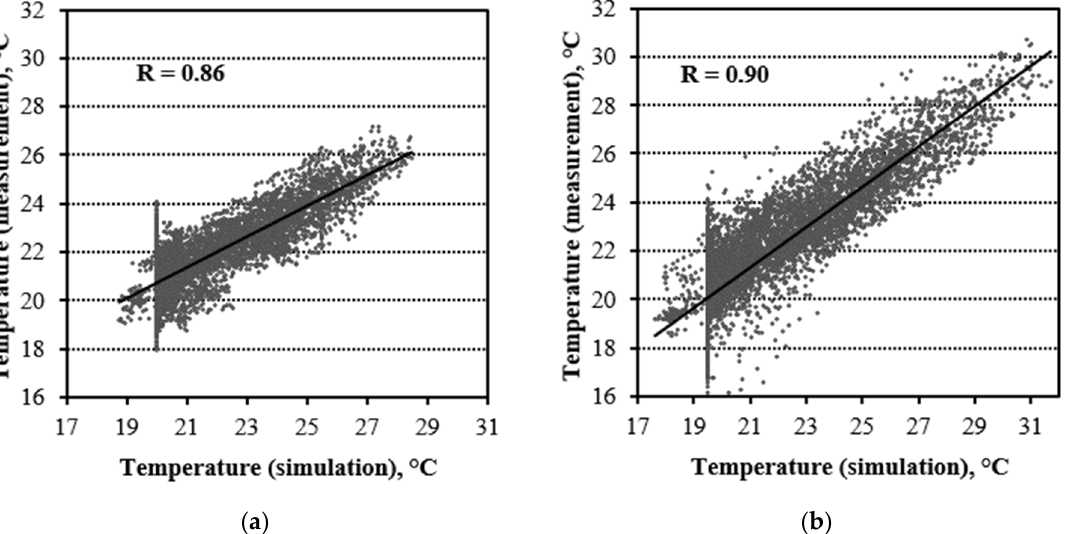
Figure 11. Correlation of the measured and calculated hourly air temperature values for level 4 of model calibration in: ( a ) the living room, ( b ) room 1.